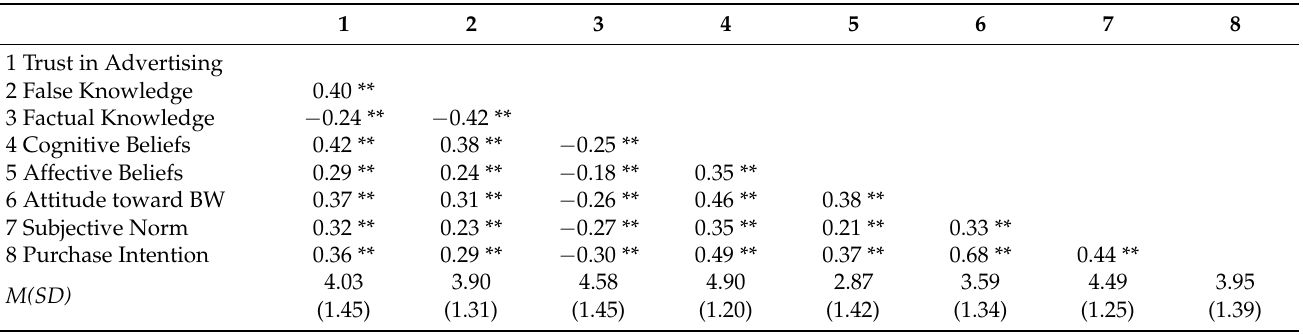
Table 1. Correlations and Descriptive